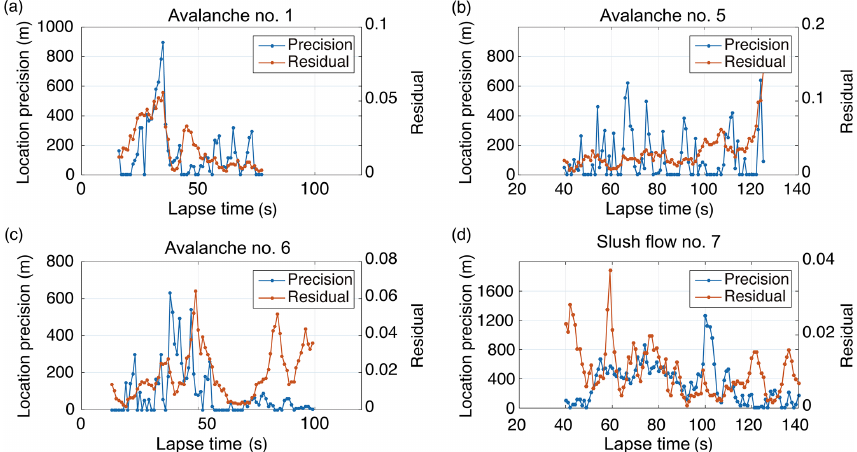
Figure 10. Location precisions and residuals estimated as a function of lapse time from the simulation start time of avalanche #1 (a) , avalanche #5 (b) , avalanche #6 (c) , and slush flow #7 (d)